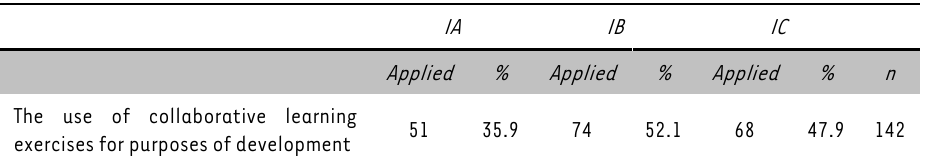
TABLE 3: Academics’ views on whether collaborative learning exercises can be applied in the development of category IA, IB and IC IA IB IC Applied % Applied % Applied % n The use of collaborative learning exercises for purposes of development